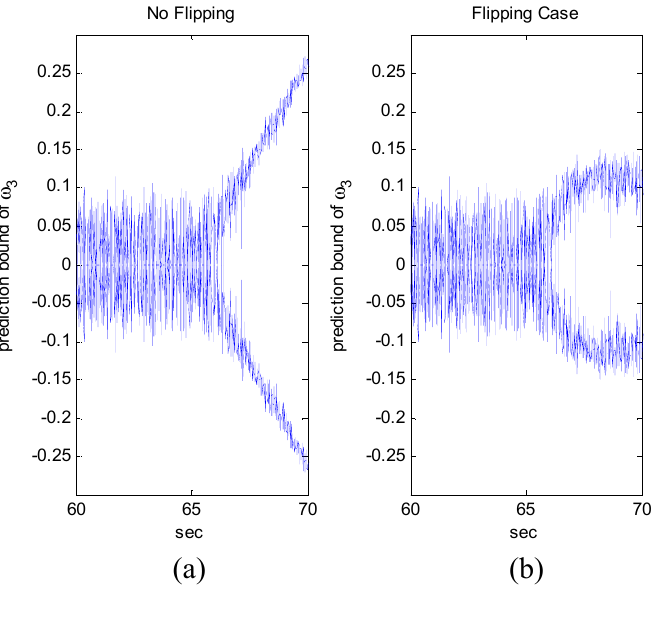
Figure 12. Response of measurement prediction covariance: ( a ) no flipping; ( b ) flipping